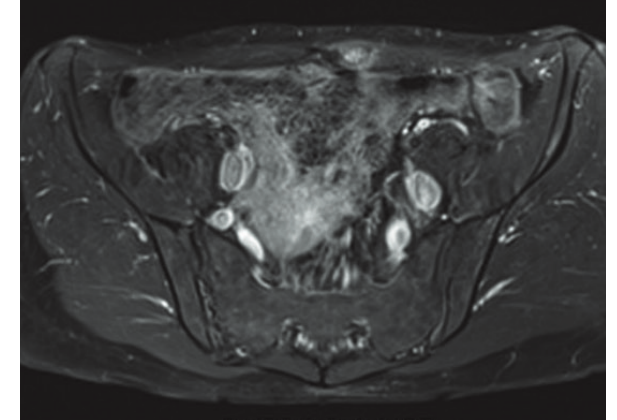
Fig. 3. Axial post-Gd T1-weighted image through